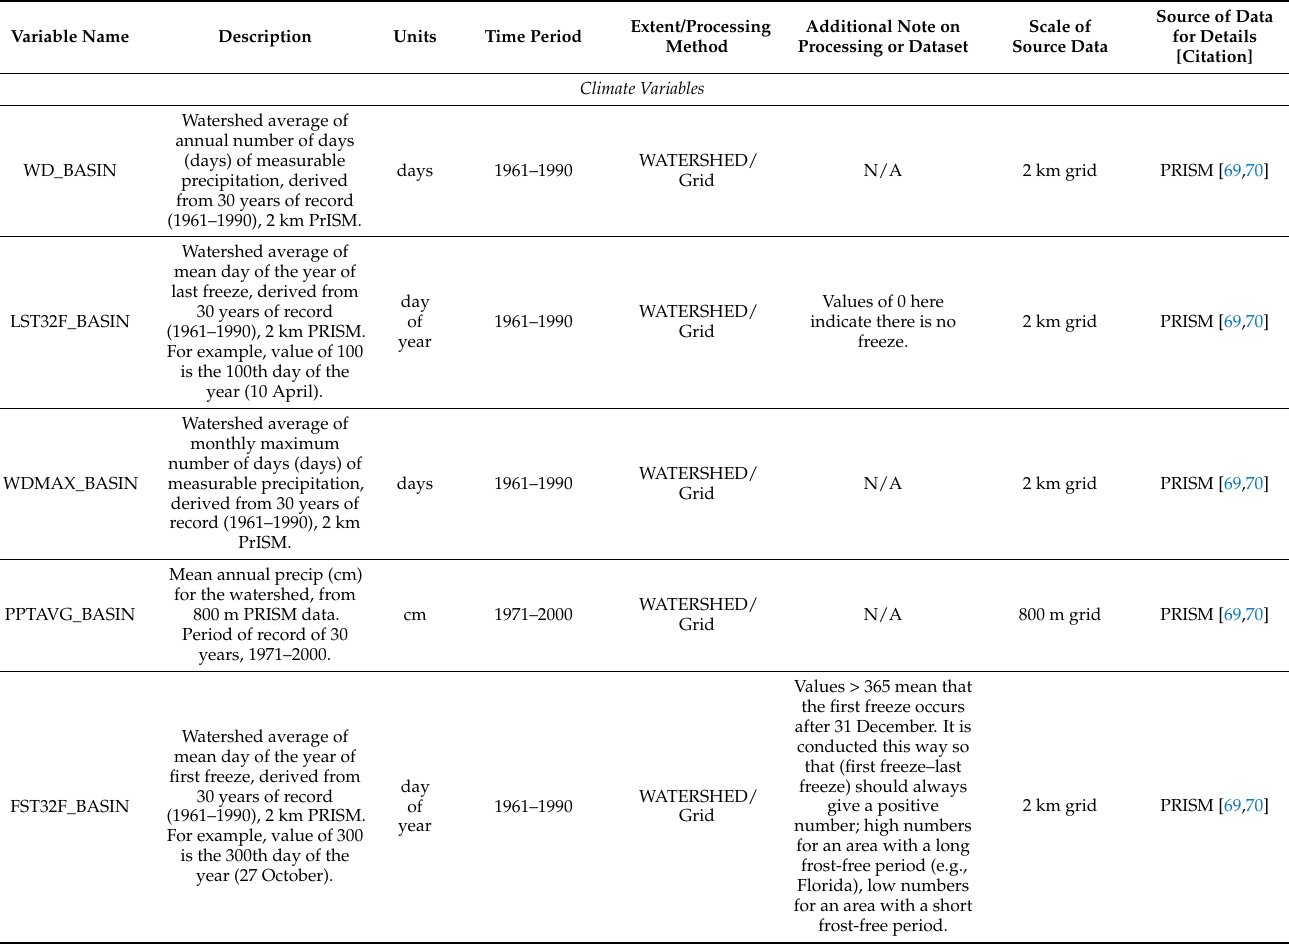
Table A1. Description of predictor variables. All information is retrieved from